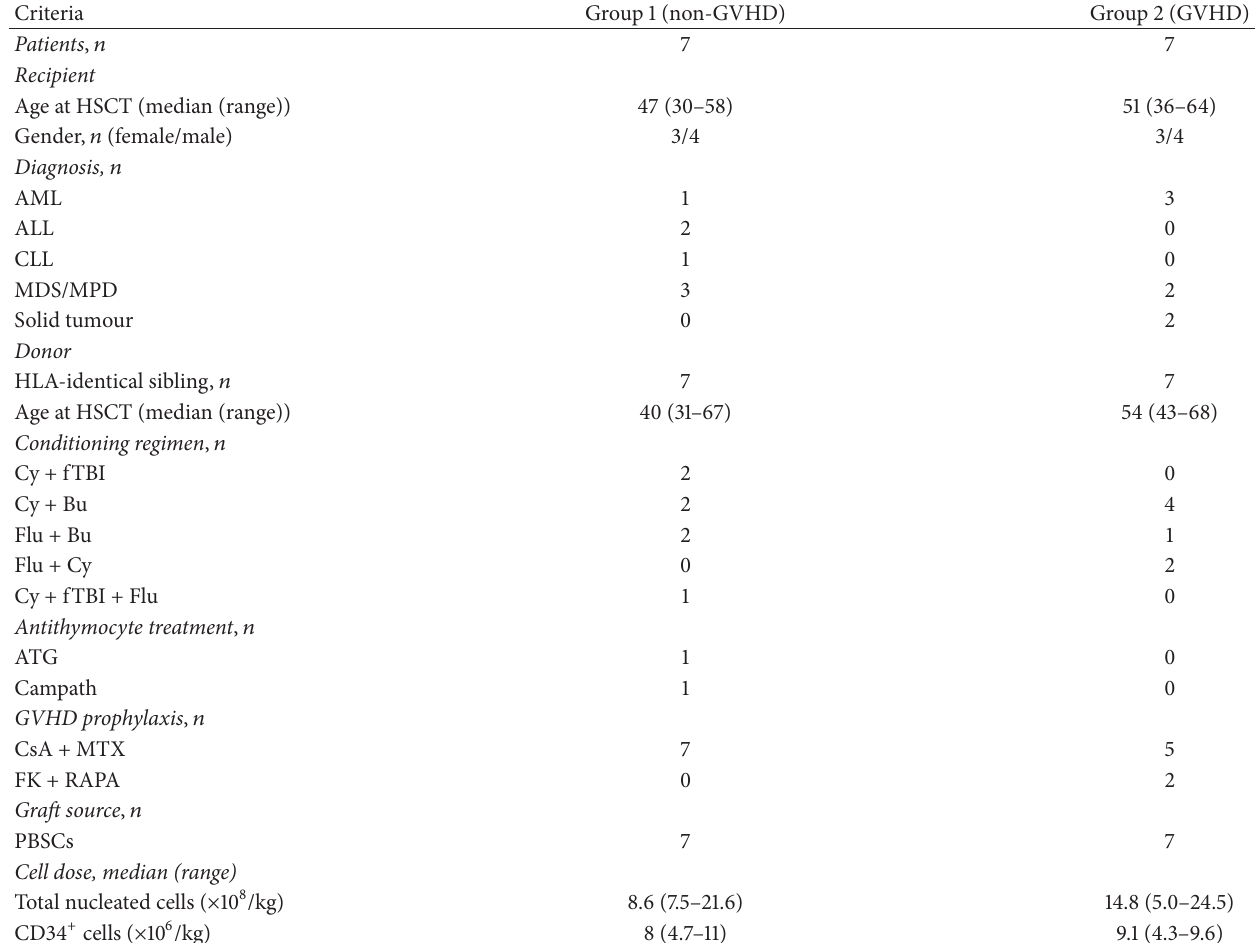
Table 1: Patient and donor